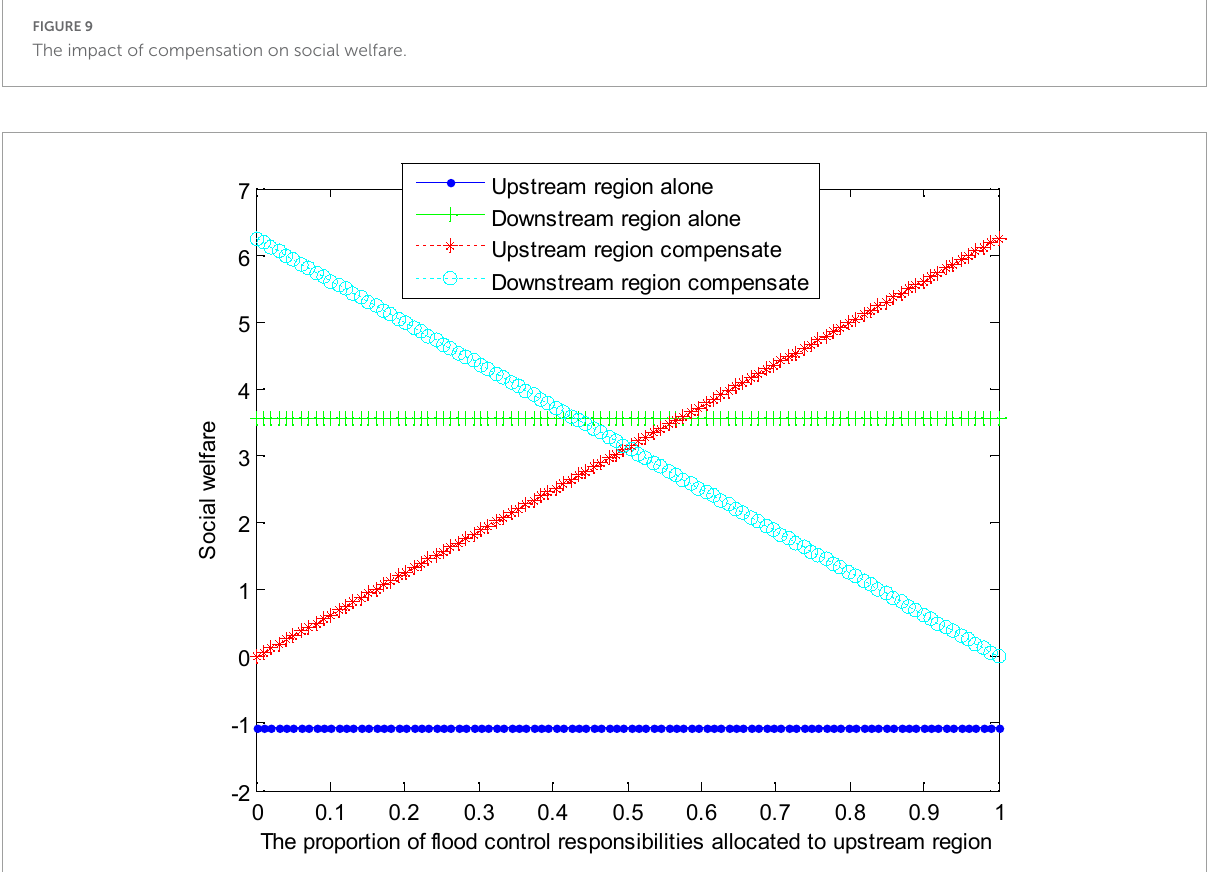
FIGURE10 The impact of allocation ratio on social